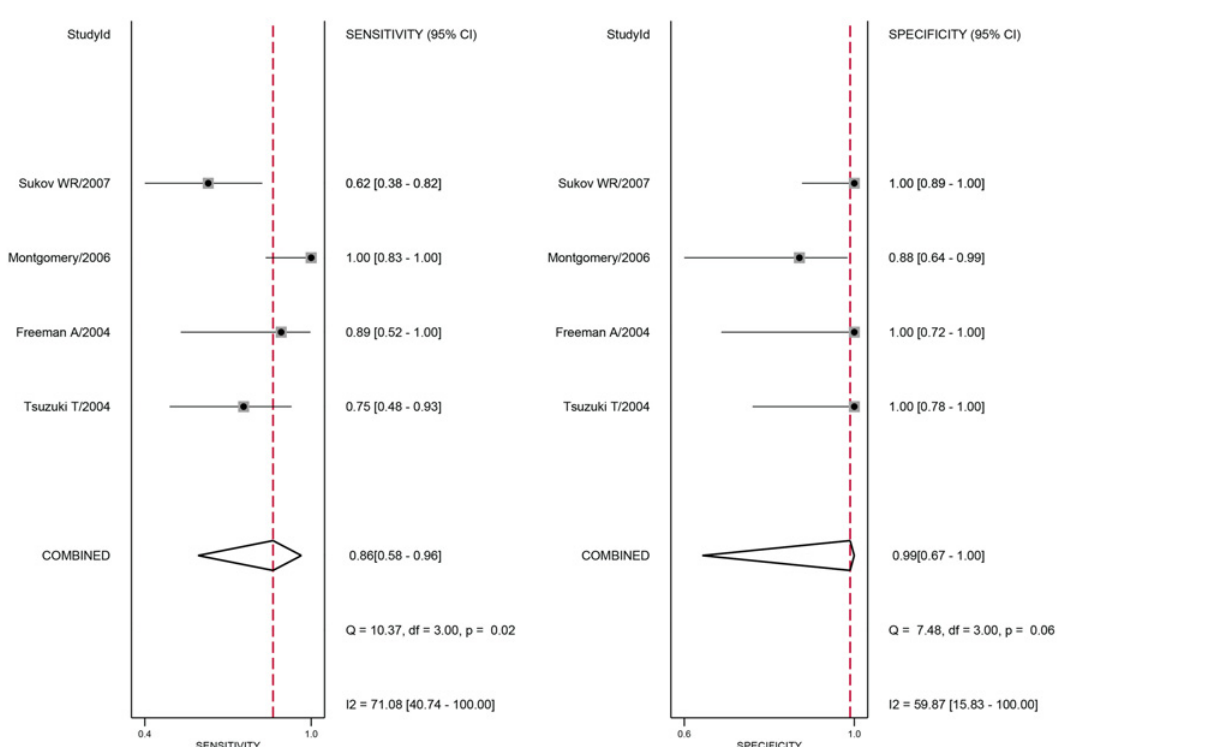
Fig 4. Forest plots of the estimates of sensitivity and specificity of bladder inflammatory myofibroblastic tumours.